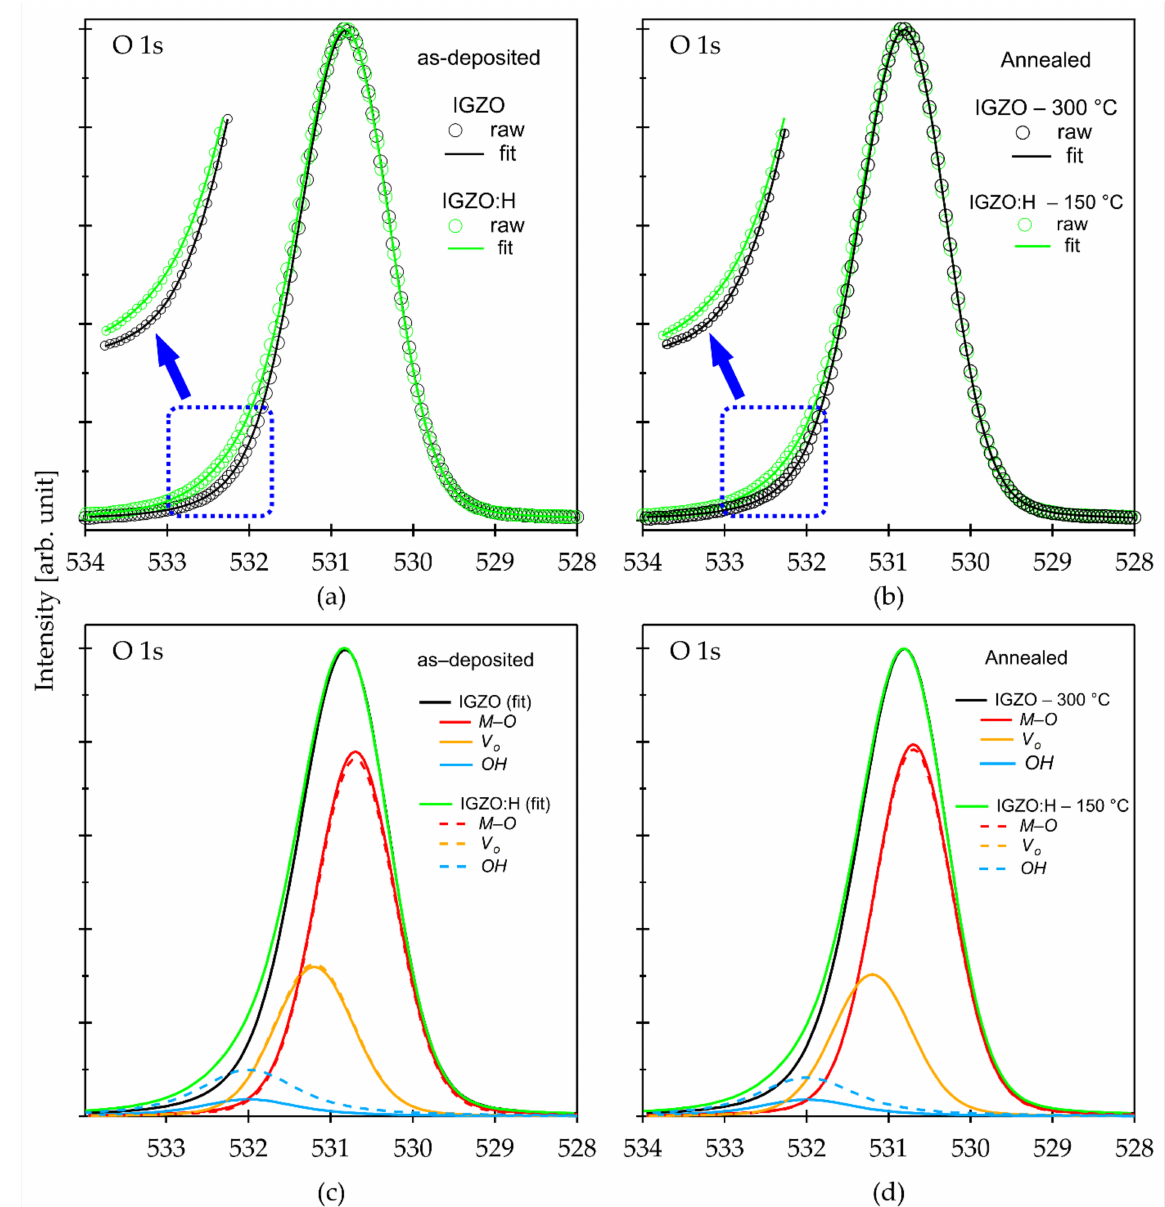
Figure 3. O 1s spectra of IGZO and IGZO:H films: ( a ) and ( c ) as-deposited before and after deconvolution, respectively; ( b ) and ( d ) annealed films in air for 1 h before and after deconvolution,